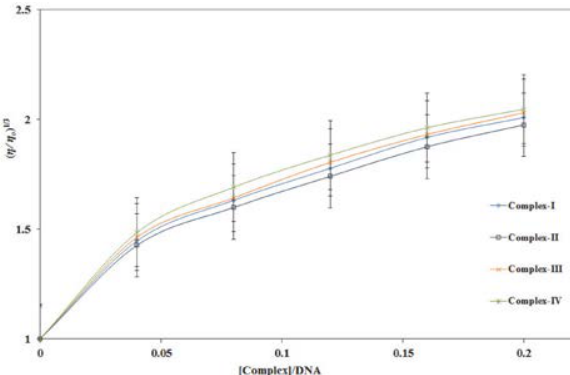
Figure 3. Effect on relative viscosity of HS DNA under the influence of increasing amount of complexes at 37 ± 0.1 °C in phosphate buff- er (pH 7.2) with standard deviation.